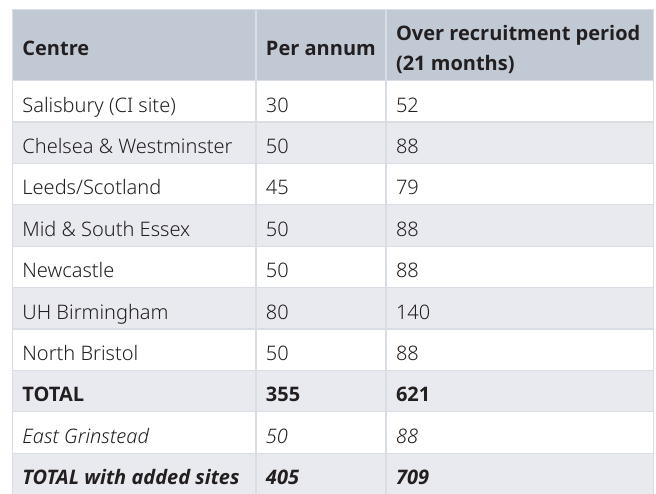
Table 1. Potential recruitment rates at each site in the